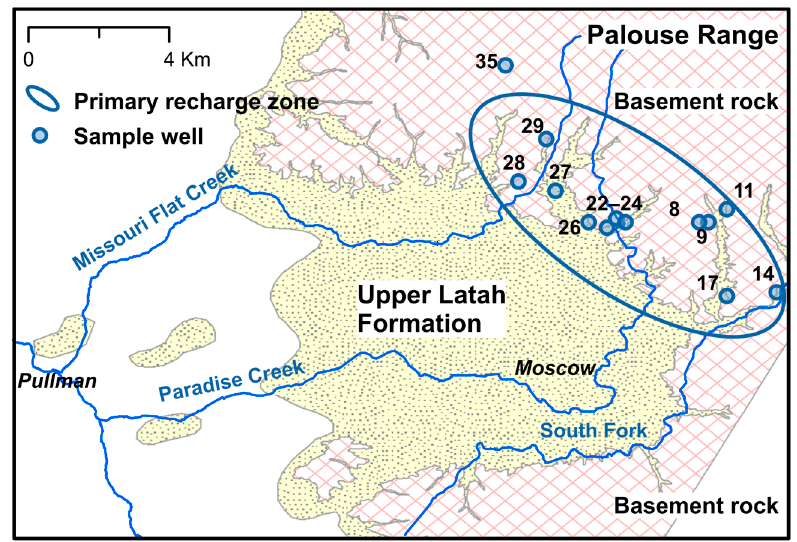
Figure 10. Wells and locations of available water isotope data for bimonthly groundwater samples collected from 2013 to 2015 in the recharge zone [46]. Table 1. Well information for wells located in the recharge zone along the mountain front of the Palouse Range. LS Elev. 2 Well No. 1